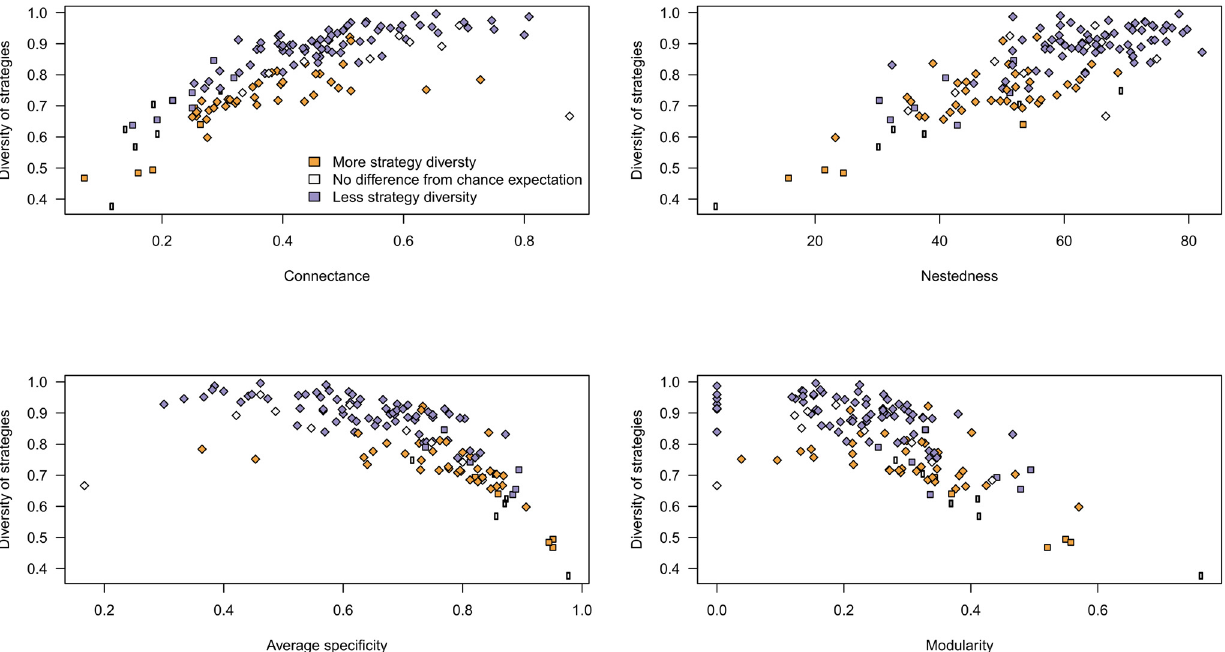
Fig 2. Values of average specificity, nestedness, connectance, and modularity for networks with more (orange) or less (purple) strategy diversity than expected by chance. The results within a type of interaction are all highly consistent. For this analysis only , networks that were as functionally diverse as expected (as determined by the Null Models) were removed, since their strategy diversity can be explained solely by either their connectance or degree distribution. Types of interaction are given on the x axis, with networks separated as a function of whether they have more (orange) or less (purple) strategy diversity than expected by chance (under the assumptions of the second, more restrictive null model).